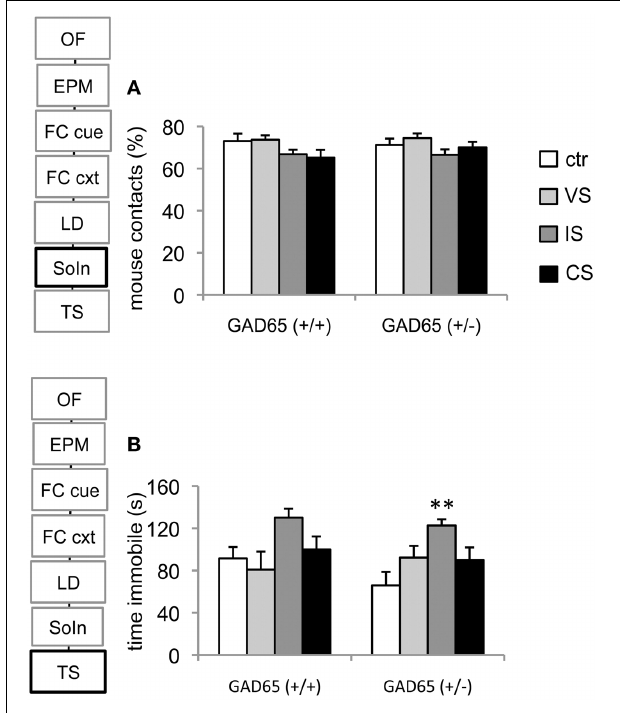
FIGURE 3 | Social interaction and tail suspension test. (A) Neither stress nor genotype had an effect on social interaction. (B) In both genotypes social isolation produced the strongest effects on depression related behavior, reaching significance in GAD65( + / − ) mice. Data are mean ± s.e.m. ∗∗ p < 0 . 05 compared to ctr.